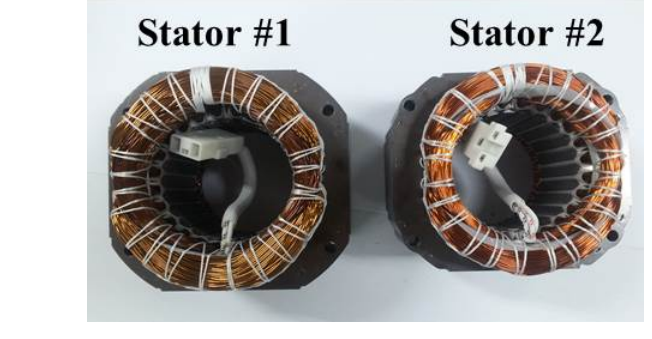
Figure 10. Fabricated prototype stators.